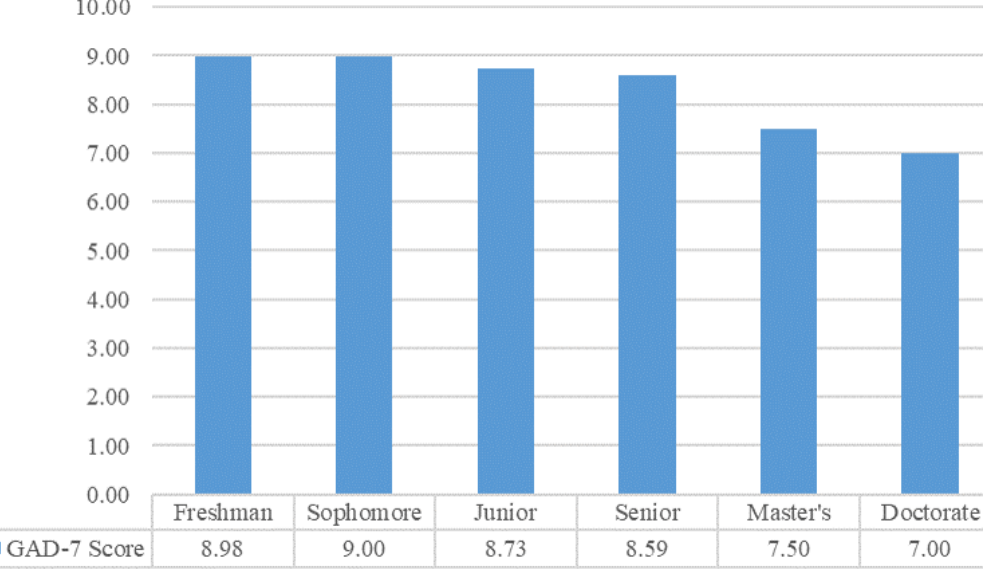
Figure 2. Mean Generalized Anxiety Disorder-7 (GAD-7) score by